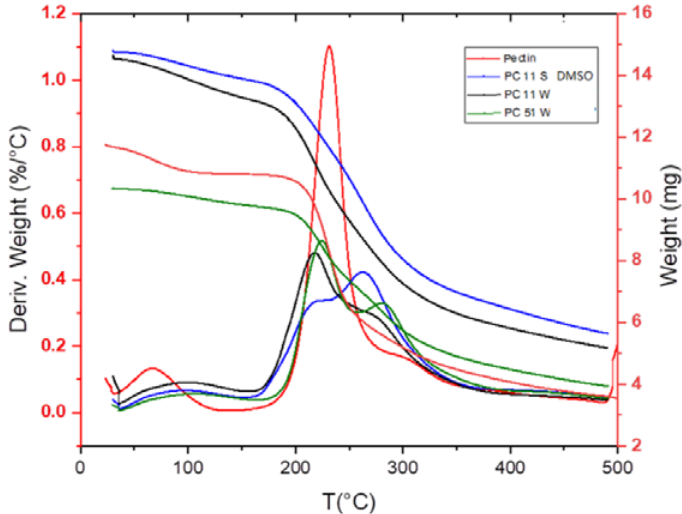
J. Compos. Sci. 2020 , 4 , 95 Figure 2. Thermal gravimetric analysis (TGA) results of pectin and pectin–chitosan composites.